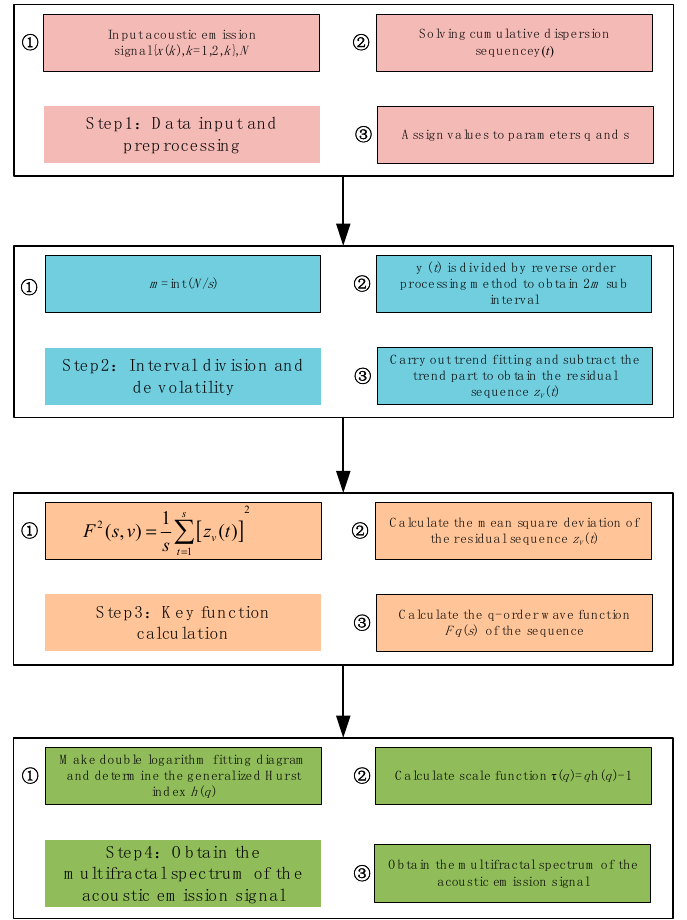
Figure 5. MF-DFA calculation flow chart.